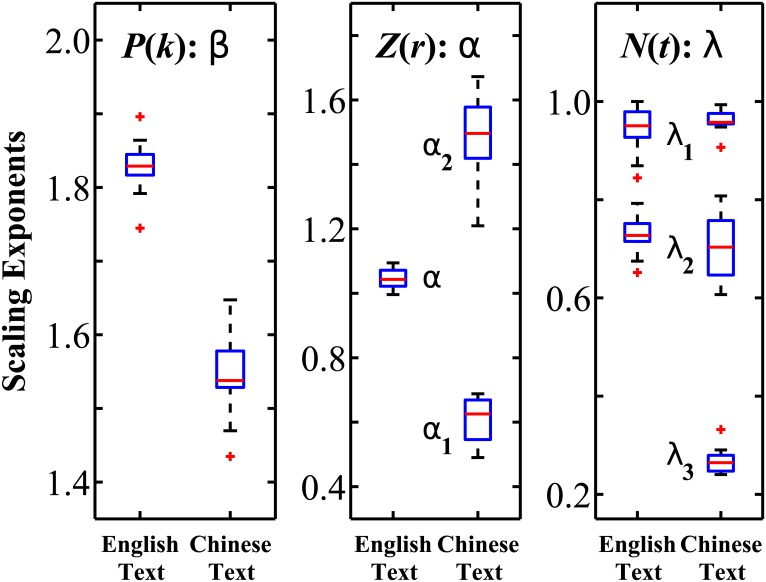
Statistical comparison of the scaling exponents derived from different scaling laws.Data show the group averaged values obtained for all books analyzed in Table 1. The central red mark in each box indicates the median value for the corresponding scaling exponents β, α and λ shown in three panels. Bottom and upper edges of each box denote the 25th and 75th percentiles correspondingly, while the whiskers extend to the most extreme data points not considered outliers; outliers are plotted individually by the symbol “+” in red color. The exponent β of the probability distribution P(k) is obtained in the range of word frequency k ∈ [1, 103] for both Chinese and English texts. The Zipf’s law scaling exponent α for English books is obtained in the range of word frequency rank r ∈ [3, 2 × 103], while for Chinese books α1 is obtained for small and intermediate scales r ∈ [3, 100] and α2 for large scales r ∈ [2 × 102, 2 × 103]. Heaps’ scaling law for both languages exhibits several scaling regimes with the exponent λ1 obtained for short scales of text length of t ∈ [1, 100] for both languages, λ2 in the scales of t ∈ [102, 2 × 104] for English texts and t ∈ [102, 3 × 103] for Chinese texts, and the exponent λ3 in long scales of t > 104 for Chinese texts only. Our analyses indicate significant differences in all three scaling exponents β, α and λ between written texts in the Chinese and English language.